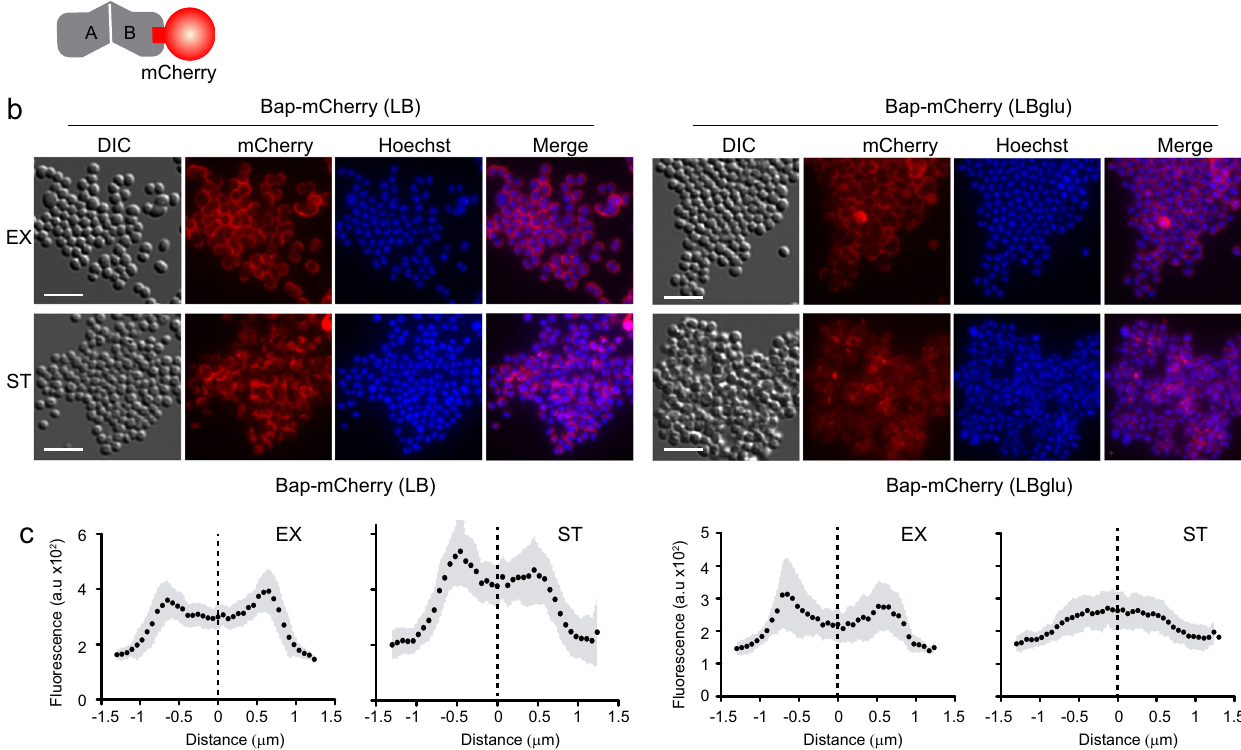
Fig. 3 Direct fl uorescent visualization of Bap-mediated multicellular behavior. a Schematic representation of Bap-mCherry fusion. b Immuno fl uorescence showing localization of Bap in S. aureus expressing Bap-mCherry grown in LB and LB-glu media at 37 °C, 200 rpm until exponential phase (EX) (OD = 0.5) and stationary phase (ST) (OD = 5). The fl uorescence of mCherry and Hoechst, the combination of both signals (merge panels) and the differential interference contrast (DIC) images are shown. Scale bar of panels represents 5 μ m. c Graphs correspond to the mean of the intensity pro fi les of cross-sections cells ( n ~20). Gray shadow corresponds to standard deviation of the